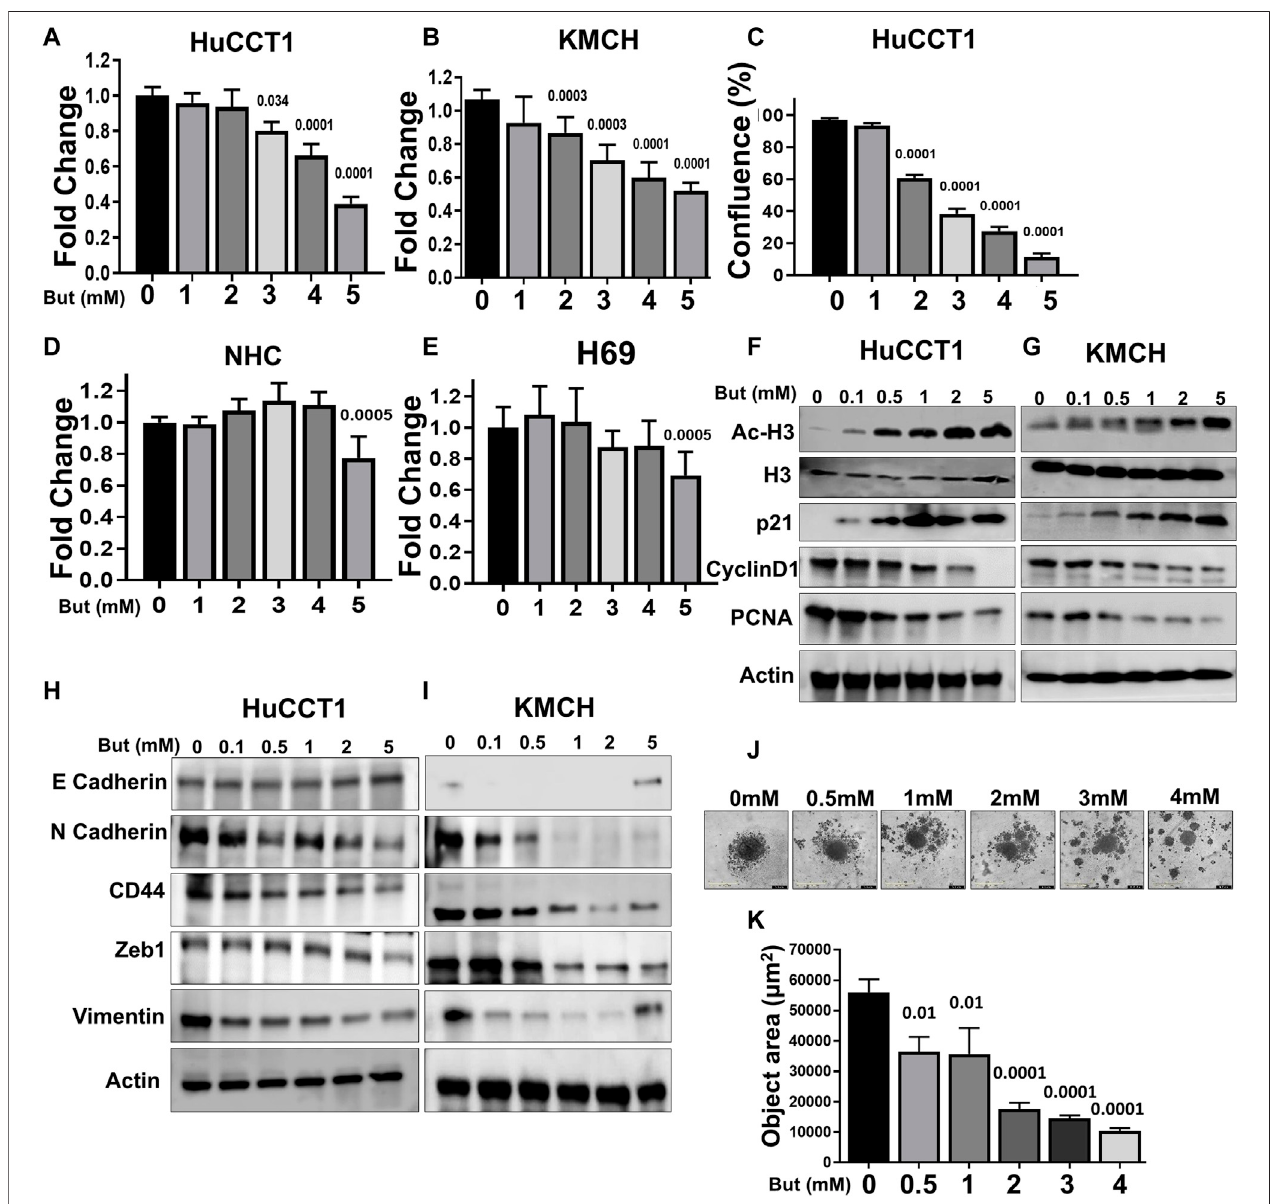
FIGURE2| Effectsofbutyrate onCCAcellproliferationandmigration. (A,B) MTScellproliferationassaywasdoneinHuCCT1 andKMCH cellsafterthetreatment of butyrate (1 – 5 mM). (C) HuCCT1 cell proliferation was determined using the IncuCyte in the presence of butyrate (1 – 5 mM). (D, E) MTS cell proliferation assay was doneinnormalcholangiocytes(NHCandH69)afterthetreatmentofbutyrate (1 – 5 mM). (F,G) HuCCT1andKMCHcellsweretreatedwithbutyrate(0.1 – 5 mM)for48 h, and Western blotting for Ac-histone H3, total histone, p21, cyclin D1, and PCNA were performed. β -Actin was used as a loading control. (H, I) The expression of E-Cadherin, N-Cadherin, CD44, Zeb1, and Vimentin using Western blots in butyrate-treated HuCCT1 and KMCH cells; β -actin was used as an internal loading control. (J, K) Spheroid formation assay was performed in the HuCCT1 cells after butyrate treatment, and spheroid area was determined using